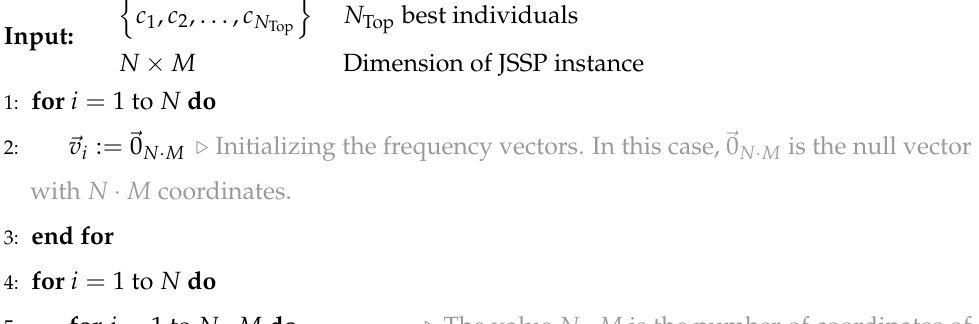
Algorithm 2 Calculating the genetic frequency of the best adapted